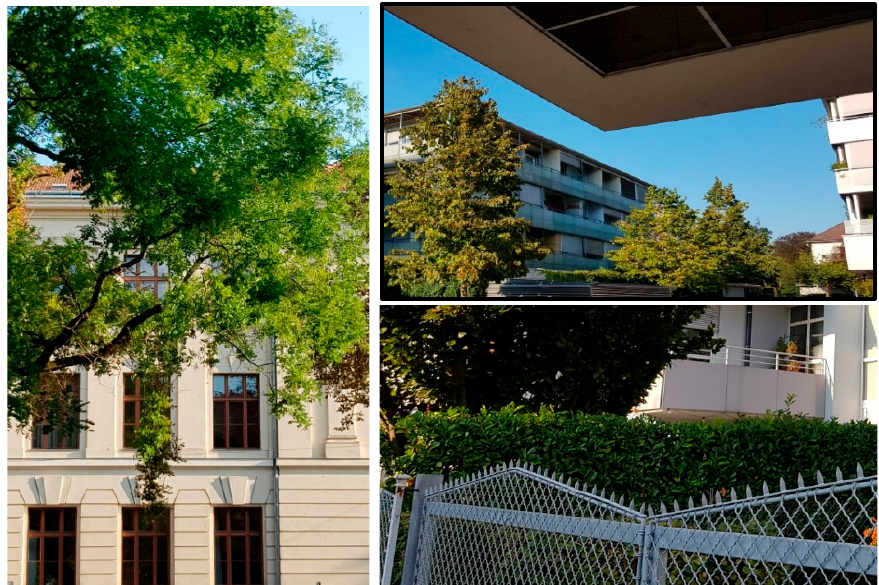
Figure 11. Image problems’ illustration: poor view/perspective, more pool garden and/or pool instead of a view of the house, etc. (Source: our own pictures).